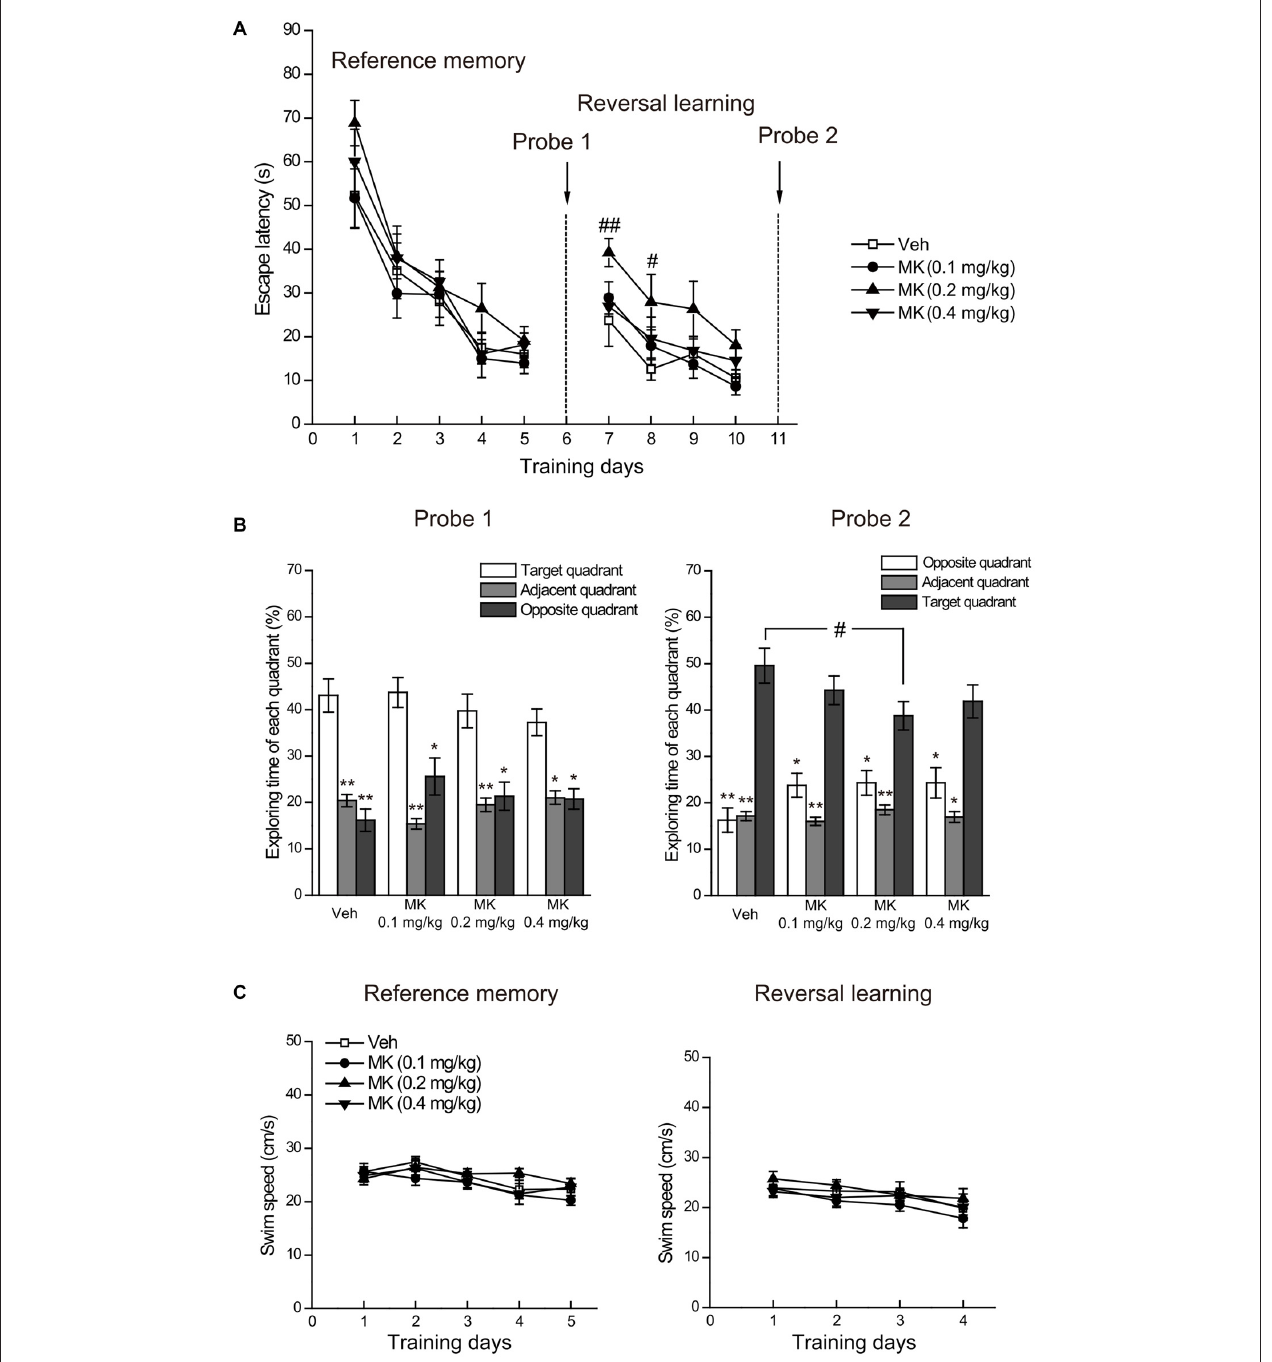
FIGURE 3 | Effects of subchronic treatment of MK-801 (0.1, 0.2, 0.4 mg/kg, once daily) during adolescence (PND 29–42) on reference memory and reversal learning in the Morris water maze. (A) Mean escape latency in the reference memory and reversal learning tasks over training days. (B) The percentage time animals swam in the target, adjacent and opposite quadrants during the probe tests. (C) Mean swim speed in the reference memory and reversal learning tasks over training days. n = 9–10 per group. ∗ p < 0.05, ∗∗ p < 0.01 compared with the target quadrant. # p < 0.05 compared with the vehicle group.